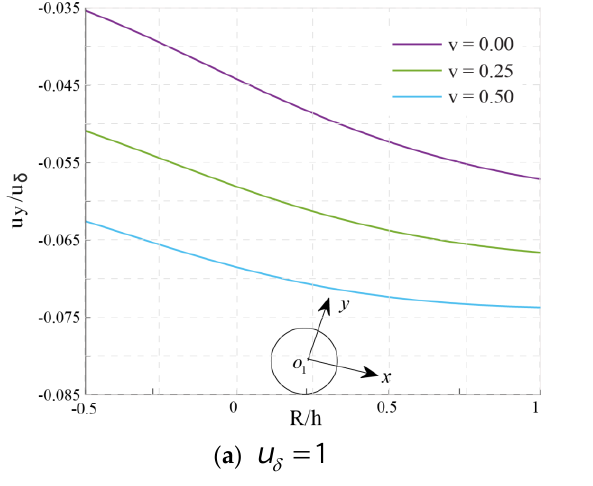
Figure 17. Vertical displacement.